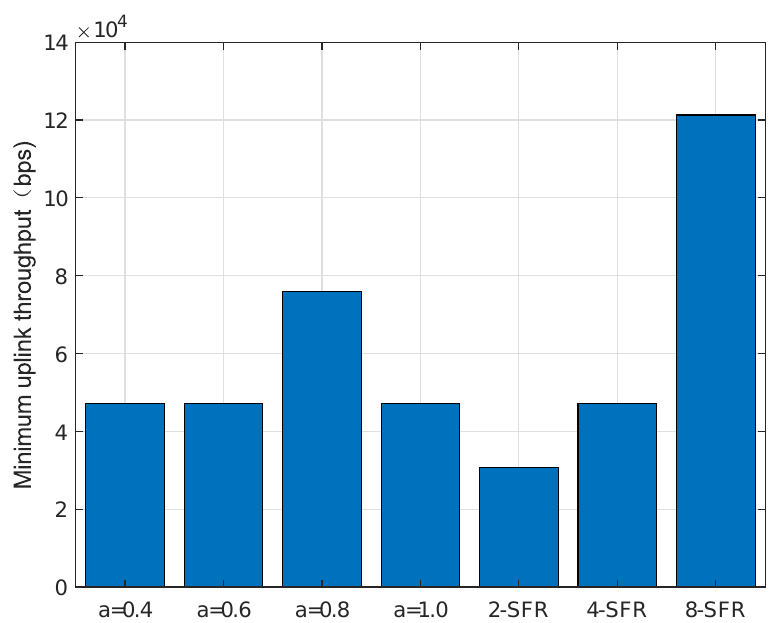
Figure 10. Minimum throughput in the uplink.